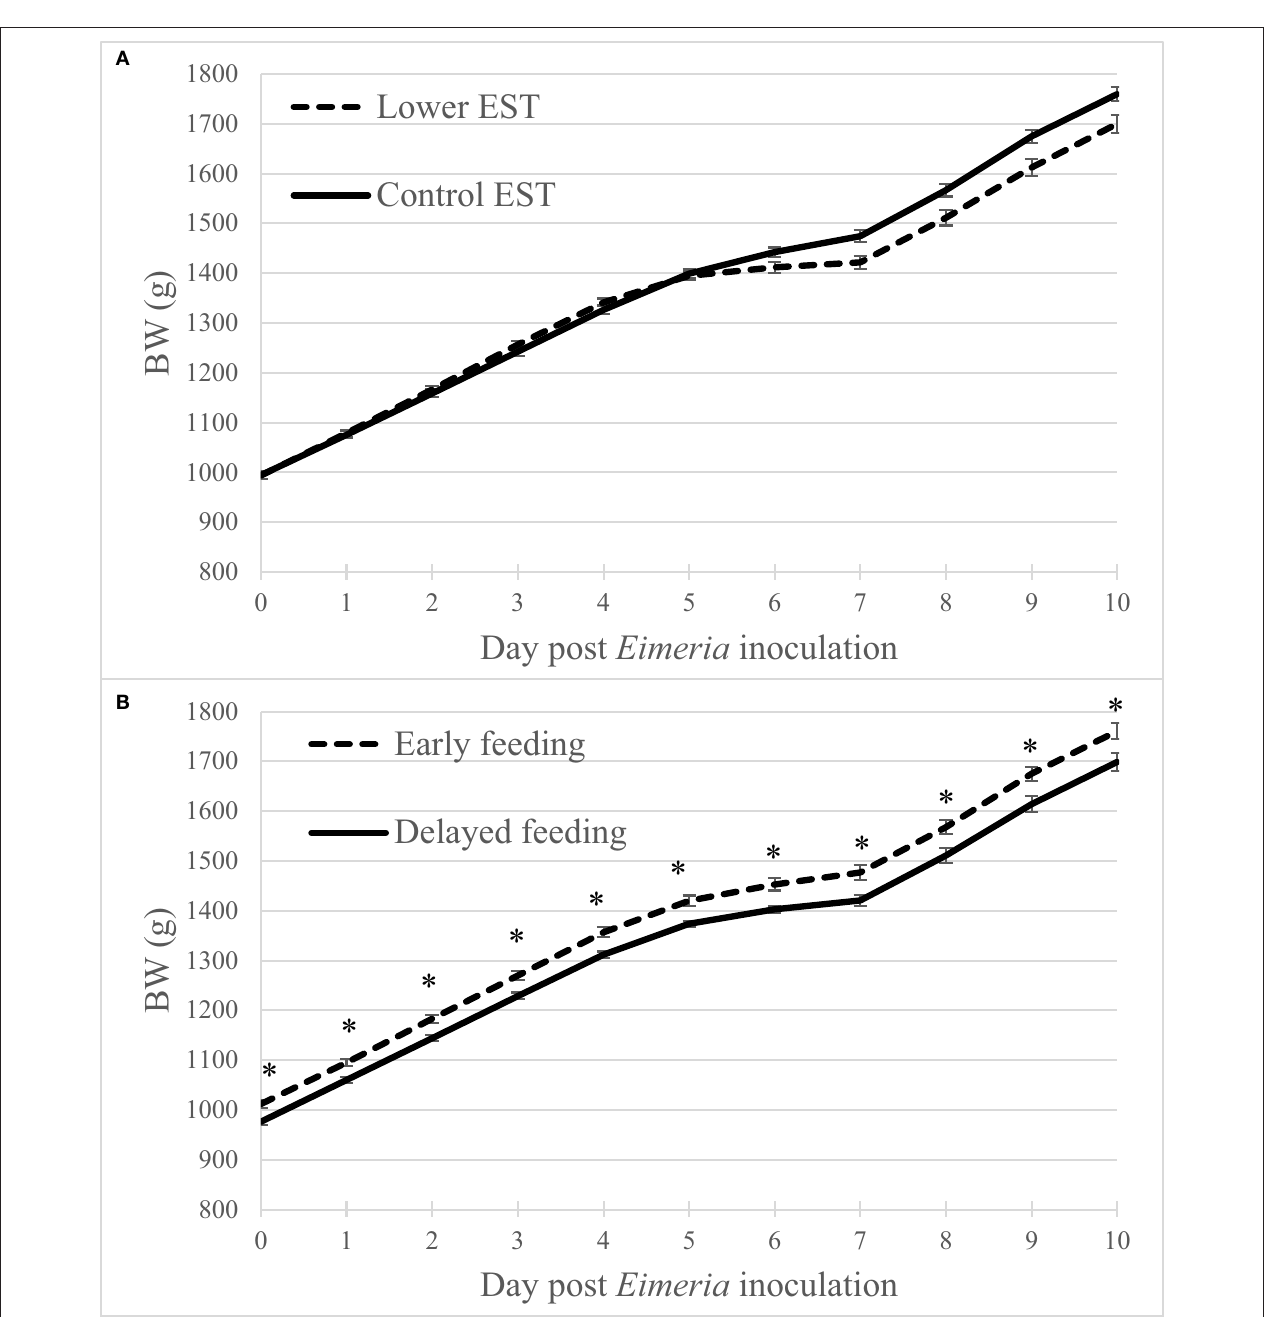
FIGURE 1 | (A) Effect of eggshell temperature ( EST ) during late incubation [ ≥ embryonic day 17–19.5; 37.8 ◦ C ( control ) or 36.7 ◦ C ( lower )] or (B) effect of feeding strategy after hatch [immediate access to feed and water ( early ) or 51–54-h deprivation ( delayed )] on broiler BW during 10 days post Eimeria inoculation (d 21 post hatch) to induce necrotic enteritis ( N = 16 pens/treatment). An asterisk (*) indicate significant difference ( P < 0.05) between LSmeans of treatments within day post Eimeria inoculation. Error bars indicate standard error.